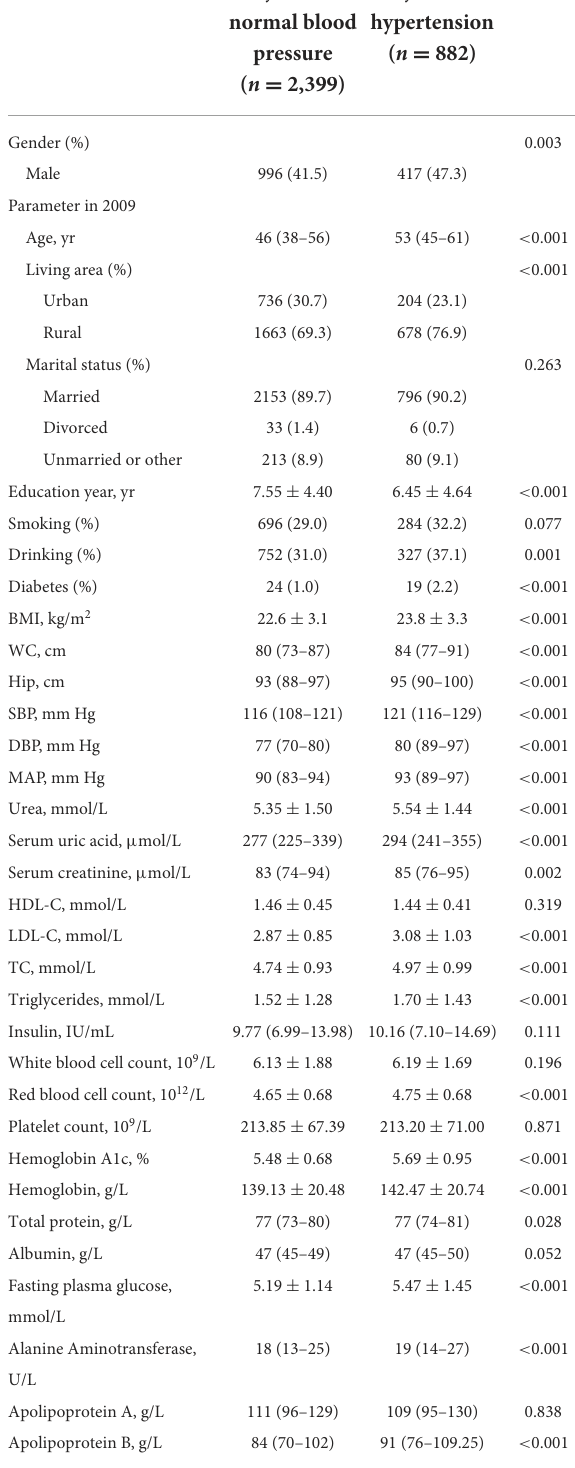
TABLE 1 Comparison of characteristics and cardiovascular risks between target population with normal blood pressure and subjects with incident